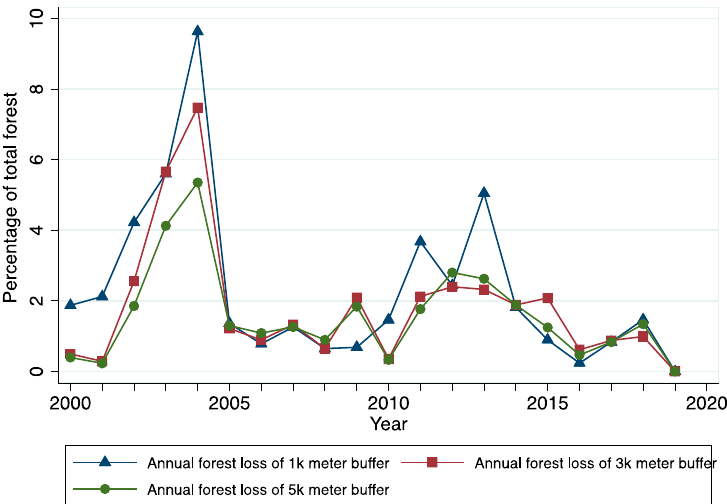
Figure 13. Yearly deforestation rate for Village E in 1000-, 3000-, and 5000-m buffers, 2000–2019 .